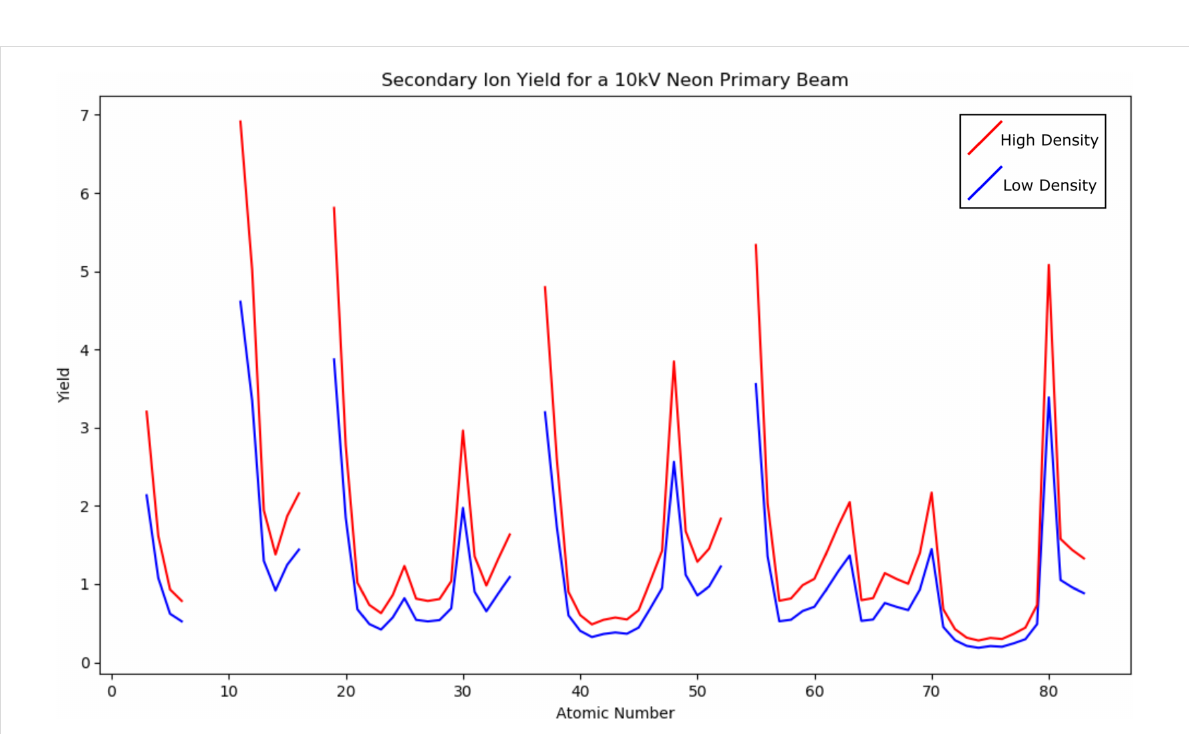
Figure 3: The calculated sputtering yield as a function of the atomic number for a 10 kV primary Ne beam impacting a silicate glass matrix for a low- density glass (2.2 g·cm − 3 , blue) and a high-density glass (3.3 g·cm − 3 , red), calculation after [17].